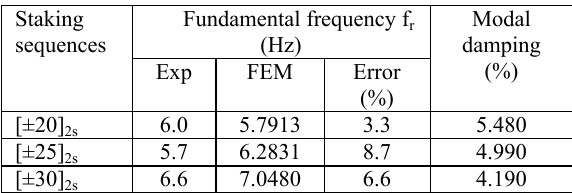
Table 5. Fundamental natural frequencies and modal damping ratio of the CFFF specimens, without attached